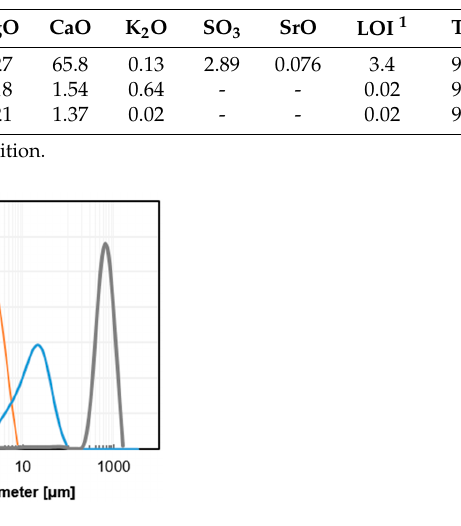
Figure 1. Particle size distribution of raw materials measured by an image analysis method for silica fume and a laser diffraction method for silica powder, white cement, and silica sand.